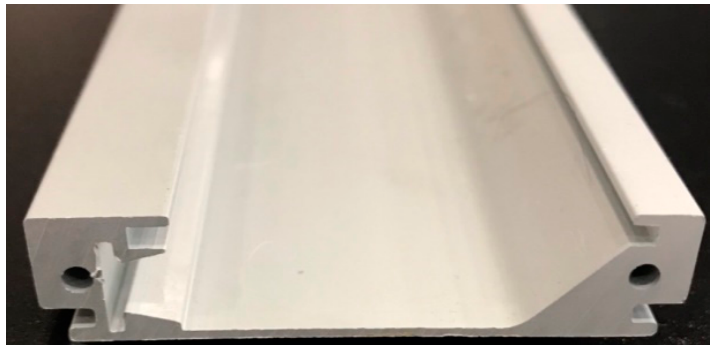
Figure 14. Archetype of light source module with VARS and beveled reflection surface.